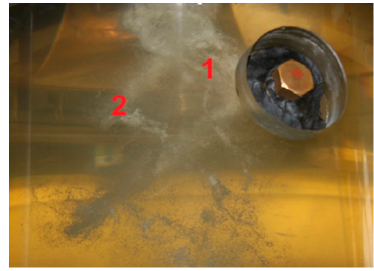
Figure 9. Photograph of a twin vortex rope taken during the experiment, with ropes 1 and 2 labelled.